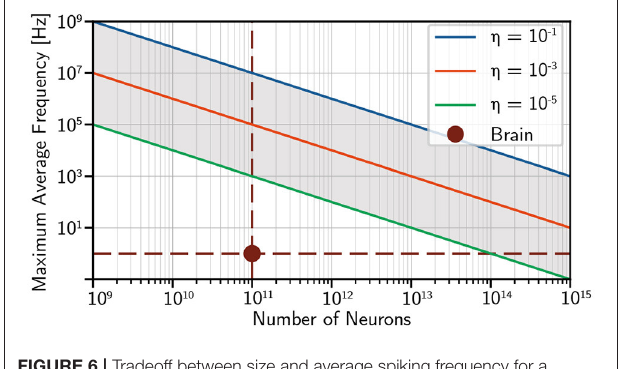
FIGURE 6 | Tradeoff between size and average spiking frequency for a population of optoelectronic neurons with a power budget of 10 MW η * 10MW . Fan-out ( N ) is 10 3 and the optical energy needed at each ( f ( N *neurons N * E opt ) = synapse is assumed to be 1fJ (accounting for cooling in superconductor case). This likely would correspond to the limits of either superconductor or semiconductor neurons.